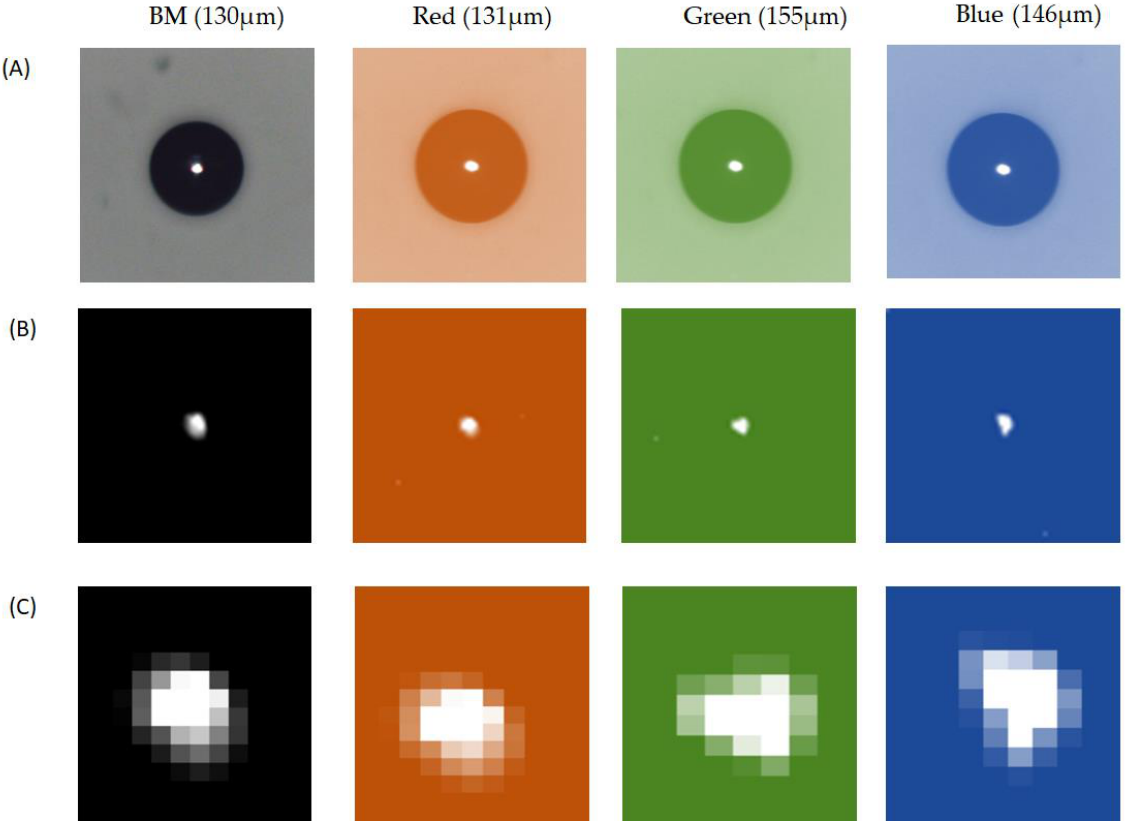
Figure 5. The golden sample coating the colored photoresists (PRs) with heights of 130, 131, 155, and 146 μm. Row ( A ) indicates the various solder balls magnified by microscope 10×, ( B ) indicates the grayscale image, and ( C ) is enlarged 1600% by Photoshop software.